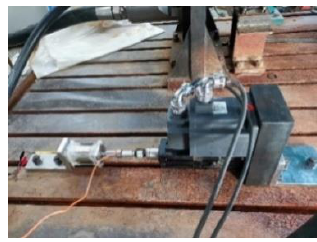
Figure 2. MR damper prototype and damping force testing platform.